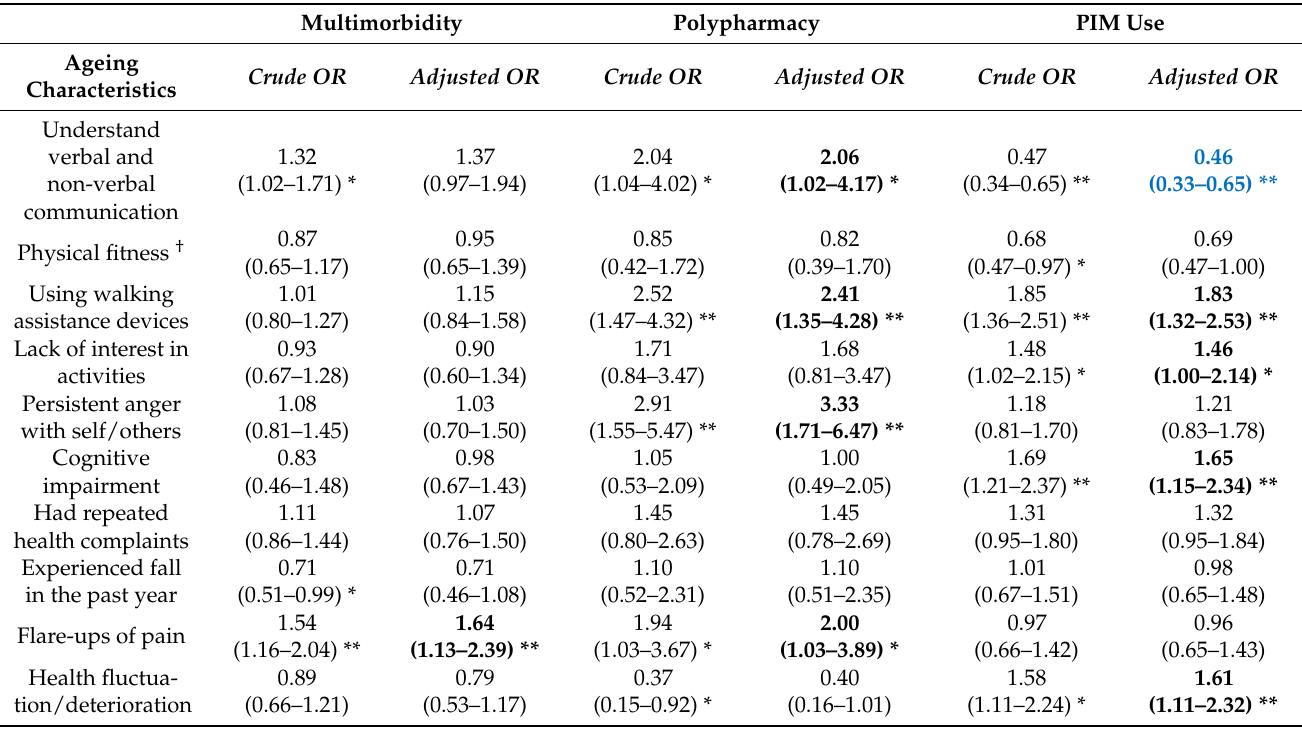
Table 3. Univariate and multivariable logistic regression analysis of determinants of multimorbidity, polypharmacy, and PIM exposure in older adults in